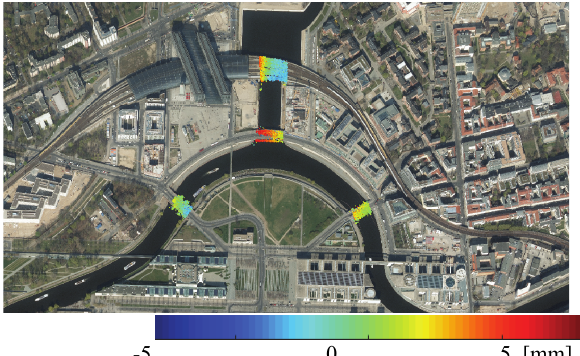
Figure 17. Overlay of the amplitude of seasonal motion of brides extracted from the TomoSAR point cloud on the optical image. The bridges are automatically detected from the classification map shown in Figure 12 using discontinuity